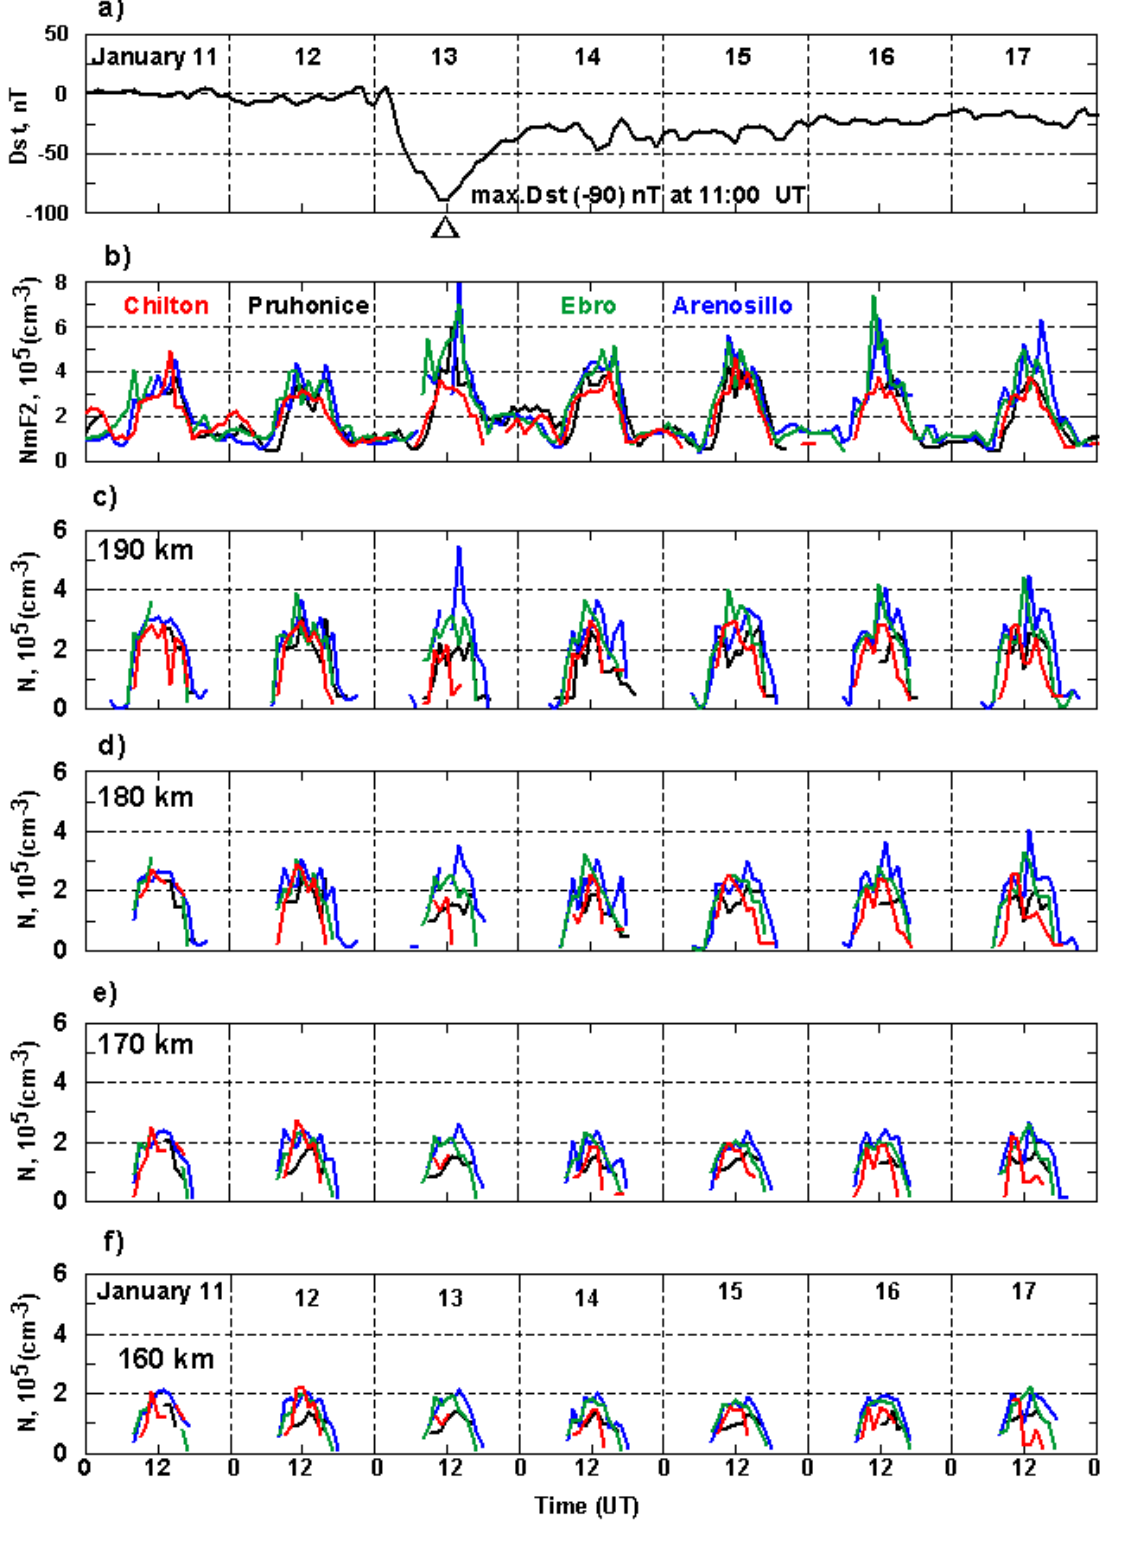
Fig. 1. Storm of January 1996: (a) hourly D st indices, (b) hourly Nm F2 values for Chilton, Pruhonice, Ebro and Arenosillo, (c–f) electron density at 190, 180, 170 and 160km, respectively, for daytime hours for all stations. Time is in